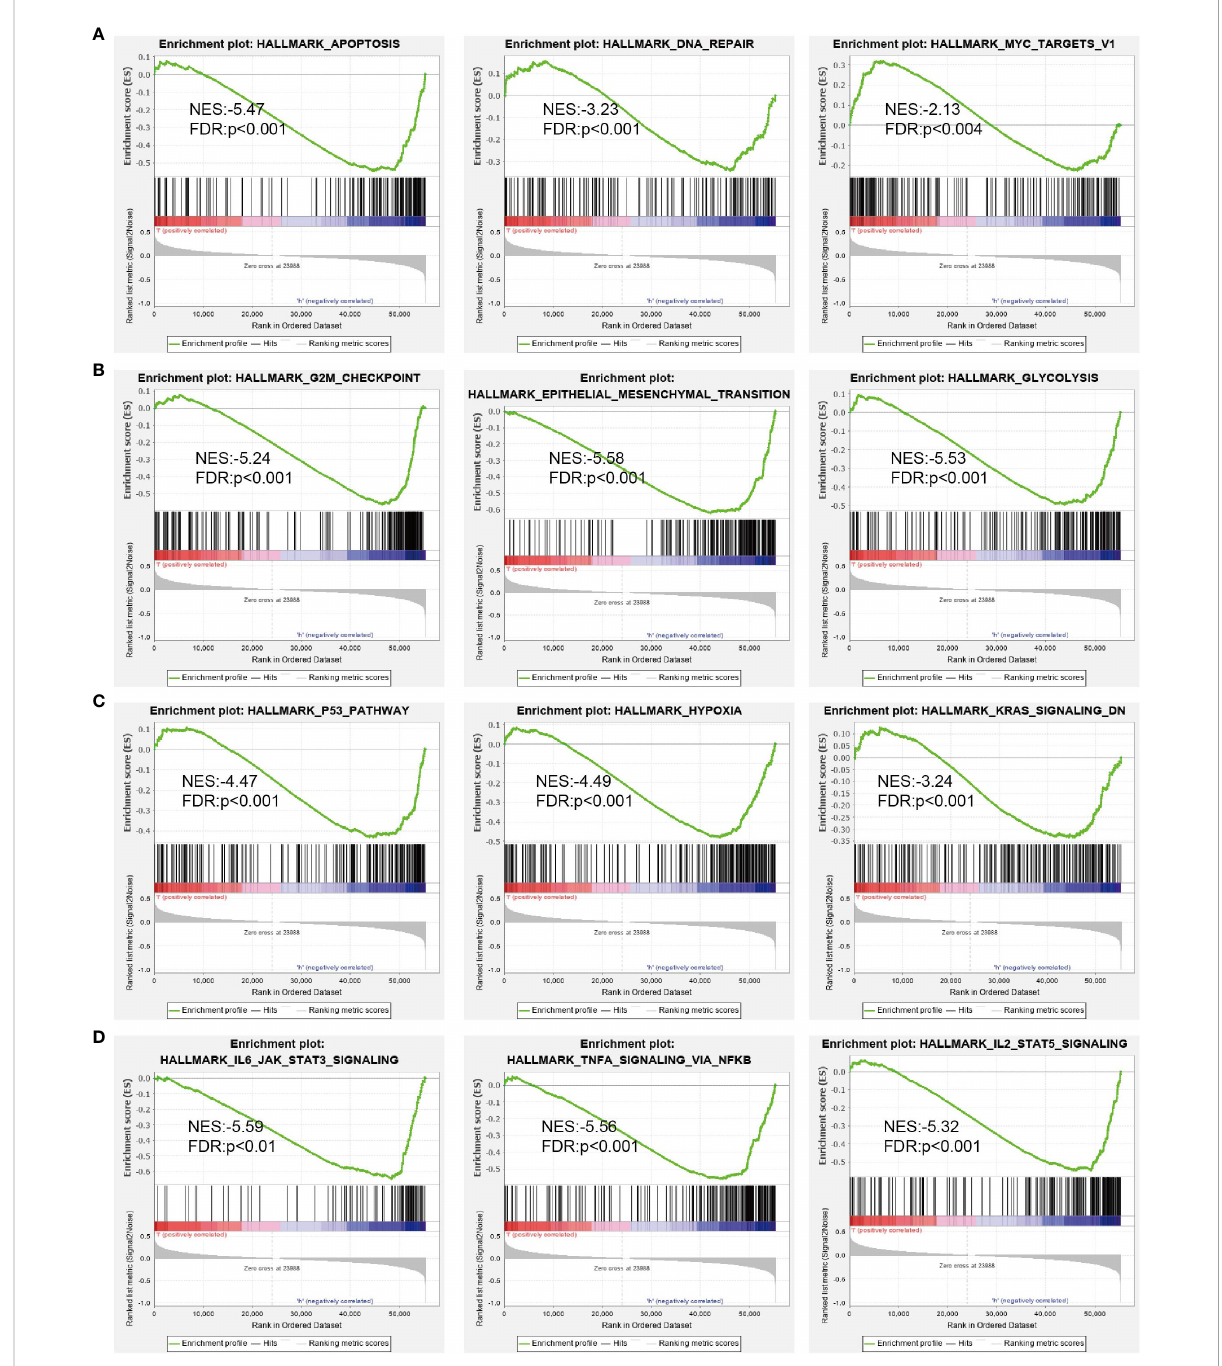
FIGURE 7 GSEA of DUSP10 based on expression in TCGA-glioma dataset (A – D) . DUSP10 was divided into high- and low-expression groups, and GSEA was performed. NES, normalized enrichment score; NOM p-value, nominal p-value; FDR q-val, false discovery rate; GSEA, gene set enrichment analysis; TCGA, The Cancer Genome